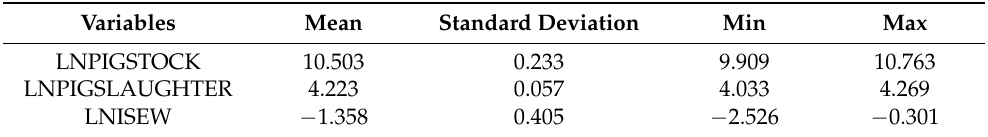
Table 1. Descriptive statistical characteristics of the